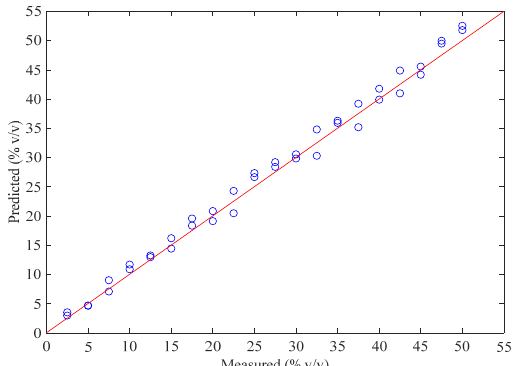
Figure 3. Reference-measured versus FT-NIR-predicted doping concentration of extra virgin olive oil (EVOO) in the validation set.